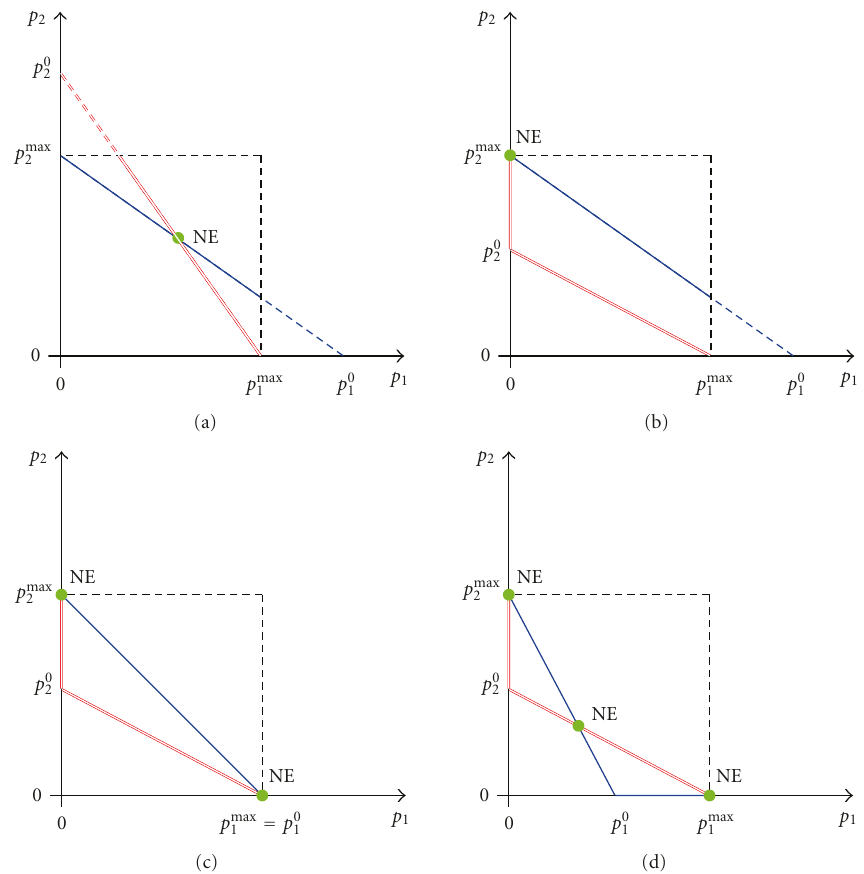
Figure 5: Illustration of the arrangement of the reaction curves. The solid blue line is l 2 ( p 1 ) given in (A.1) and the double solid red line is l 1 ( p 2 ) given in (A.2). The dashed lines are the corresponding unbounded reaction curves. According to Table 1, (a) corresponds to case 3. (b) corresponds to case 1 and analogously to case 2. (c) corresponds to case 4 and analogously to case 5. (d) corresponds to case 6. Case 7 occurs when the curves